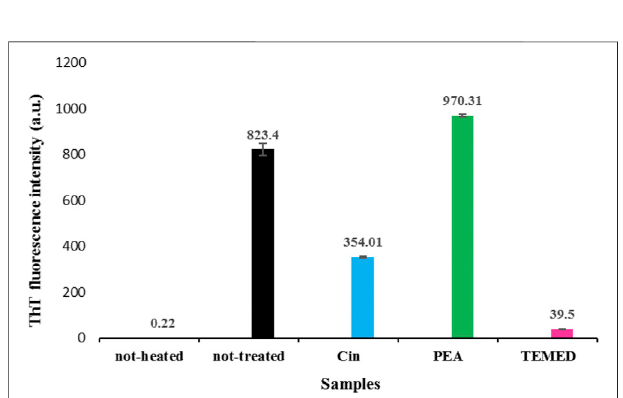
FIGURE4| ThTanalysisoftau fi brillationinthepresenceandabsenceof the volatile compounds Cin, PEA, and TEMED, after 96 h of incubation. The results are based on an average of two to three repetitions, and the difference in the intensities of the emissions are compared to that of the two controls including the not-heated and not-treated samples. Tau protein sampleswereusedin fi brillationstudiesasdescribedbythesetupin Figure1 . ThT emission was measured at 484